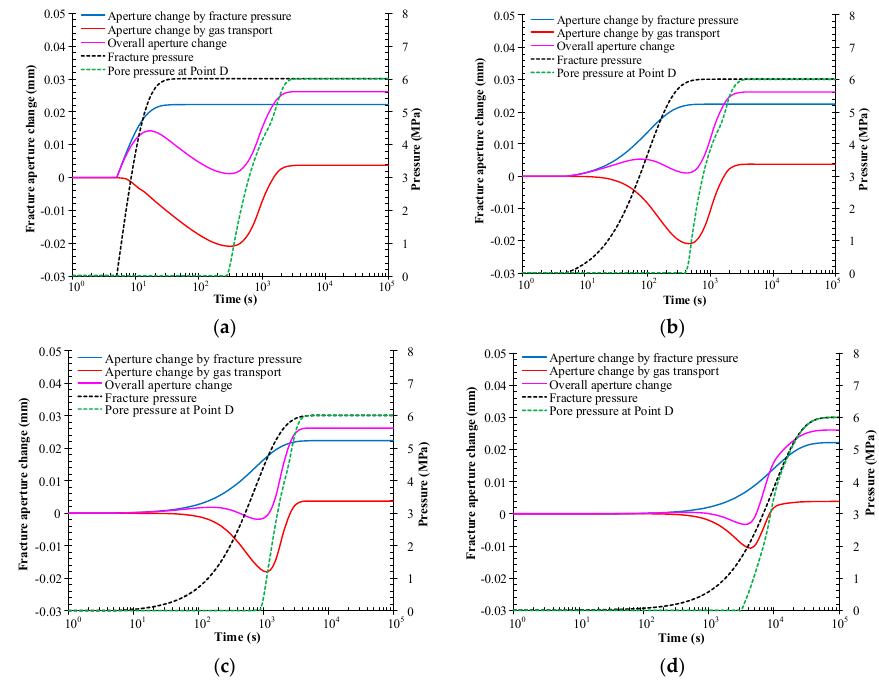
Figure 13. Evolution of each component in overall aperture change from fracture pressure and pore pressure at Point D at different injection characteristic times. ( a ) t d = 5 s; ( b ) t d = 100 s; ( c ) t d = 750 s; ( d ) t d = 10000 s.